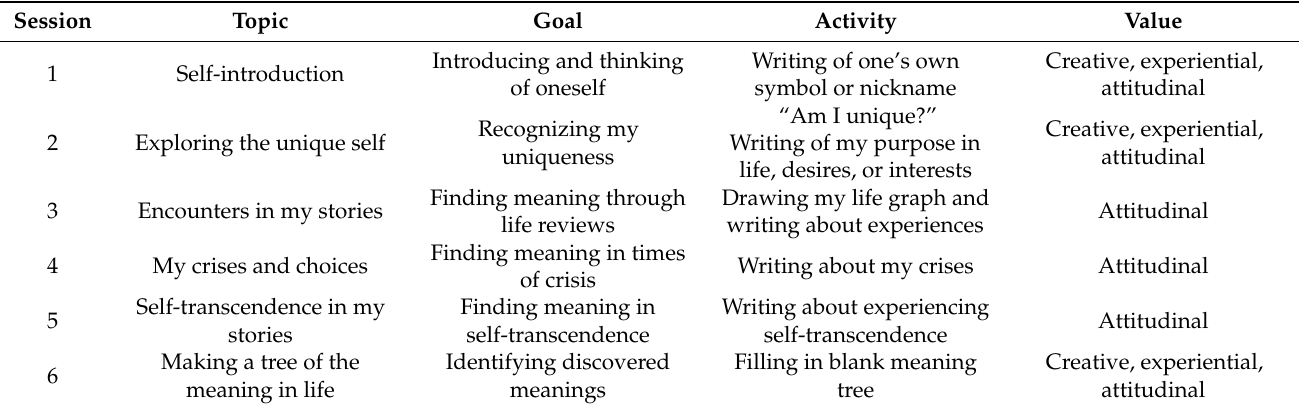
Table 1. Topic, goal, activity, and value in LAC 1 .